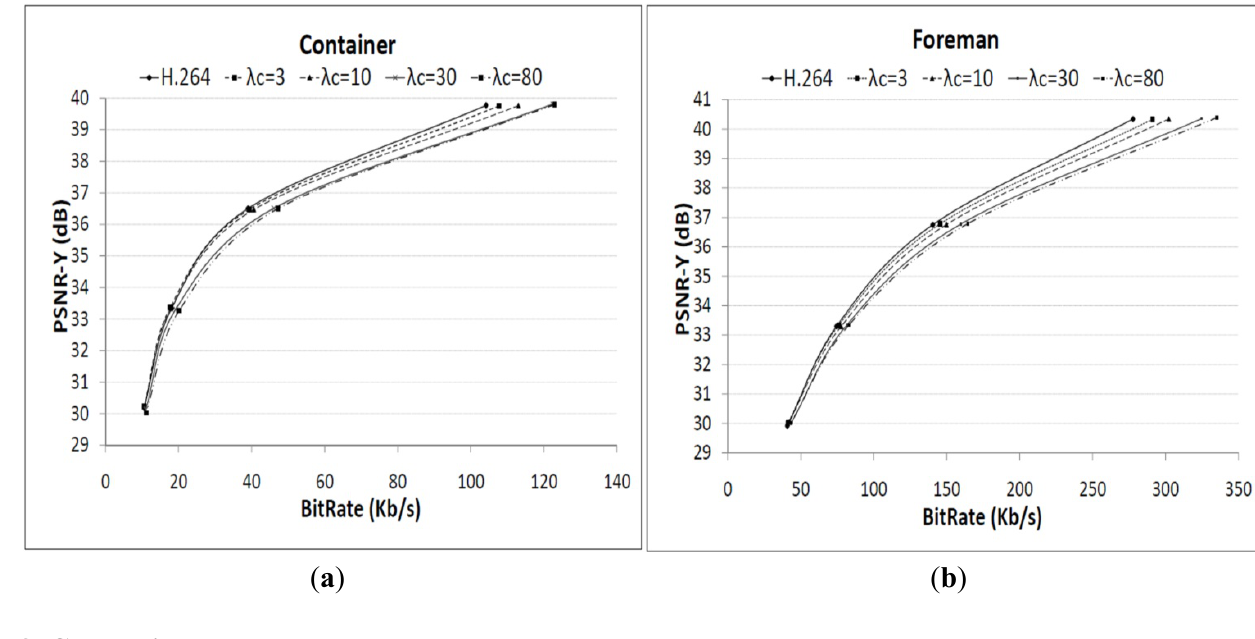
. ( a ) Container; ( b ) (cid:2159)